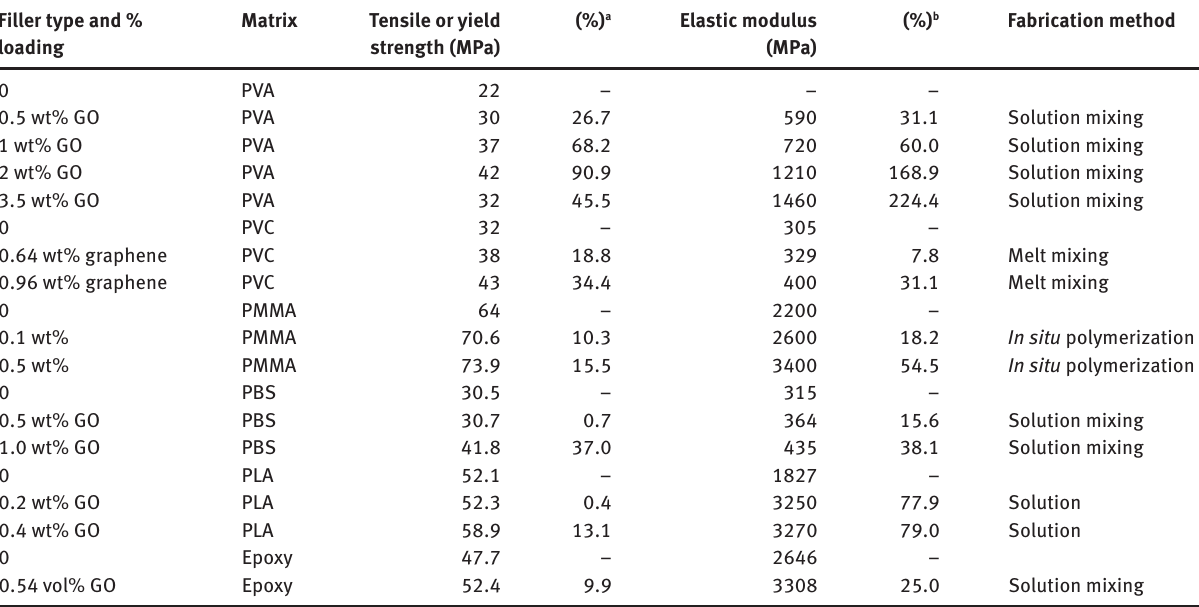
Table 2: Mechanical properties of graphene/polymer composite from the literature [69]. Filler type and %